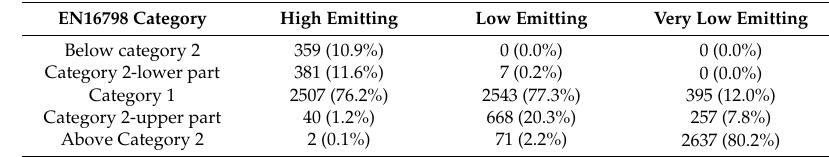
Table 7. Number of hours from 15 May to 30 September in the EN16798 categories for the three configurations (absolute and percentage figures).